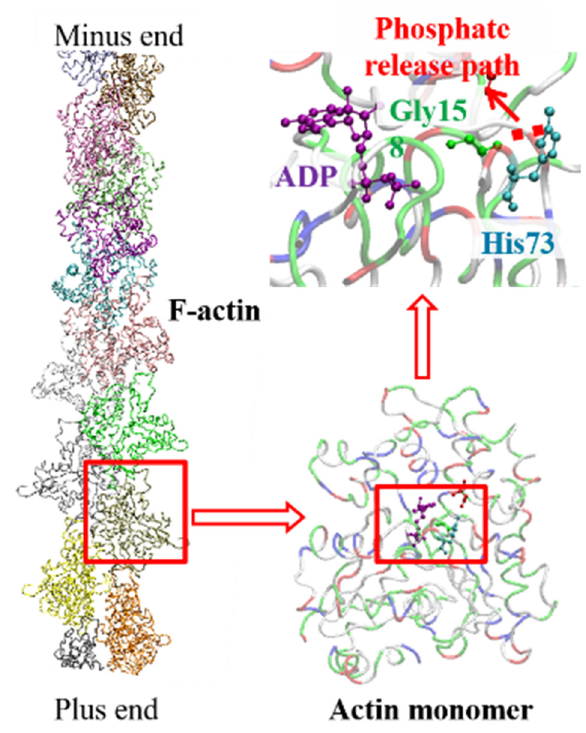
Figure 2. The structural basis for material exchange in F-actin dynamics. The interactions between His73 and Gly158 [8,11] were reported to be important in stabilizing the atomistic networks on actin. The connections between these residues are disrupted during the nucleotide exchange, which helps to create the pathway for material exchange. Once the Pi releases, its mother globular actin would gradually reach the minus end of the actin filament and depolymerize from F-actin.